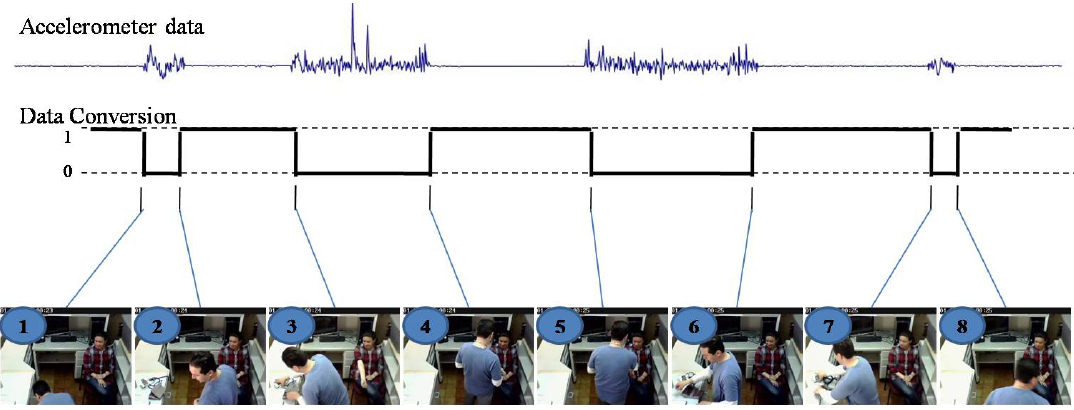
Figure 7. Accelerometer